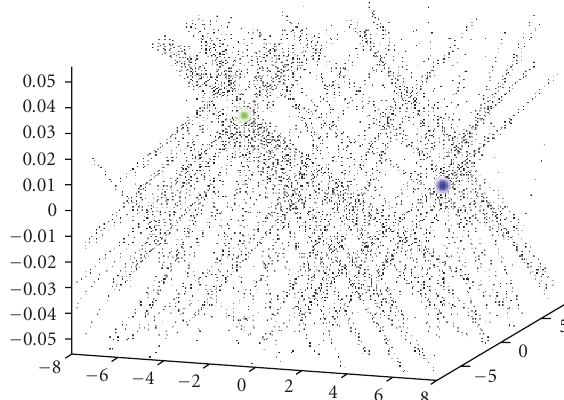
Figure 4: Accumulation matrix in the space ( a 1 , a 4 , a 2 ), built from the displacements computed by a transparent block-matching technique. These displacements are presented on the left of Figure 5. The ground truth of the two motion models present in the image sequences are plotted in green and